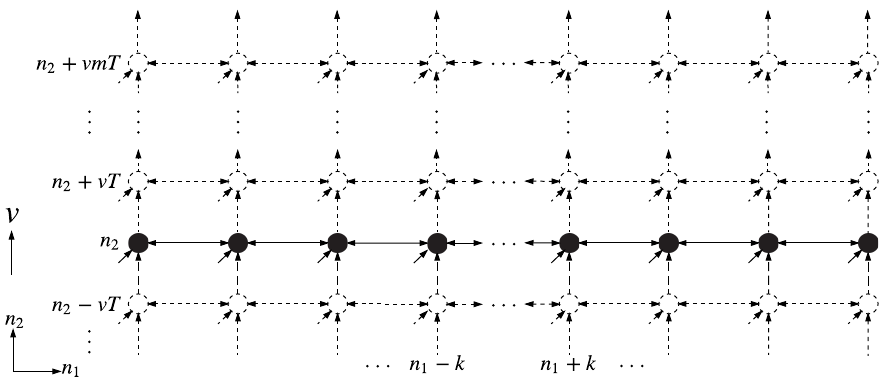
Figure 3. Roesser Model Based Distributed Processing in 1-D